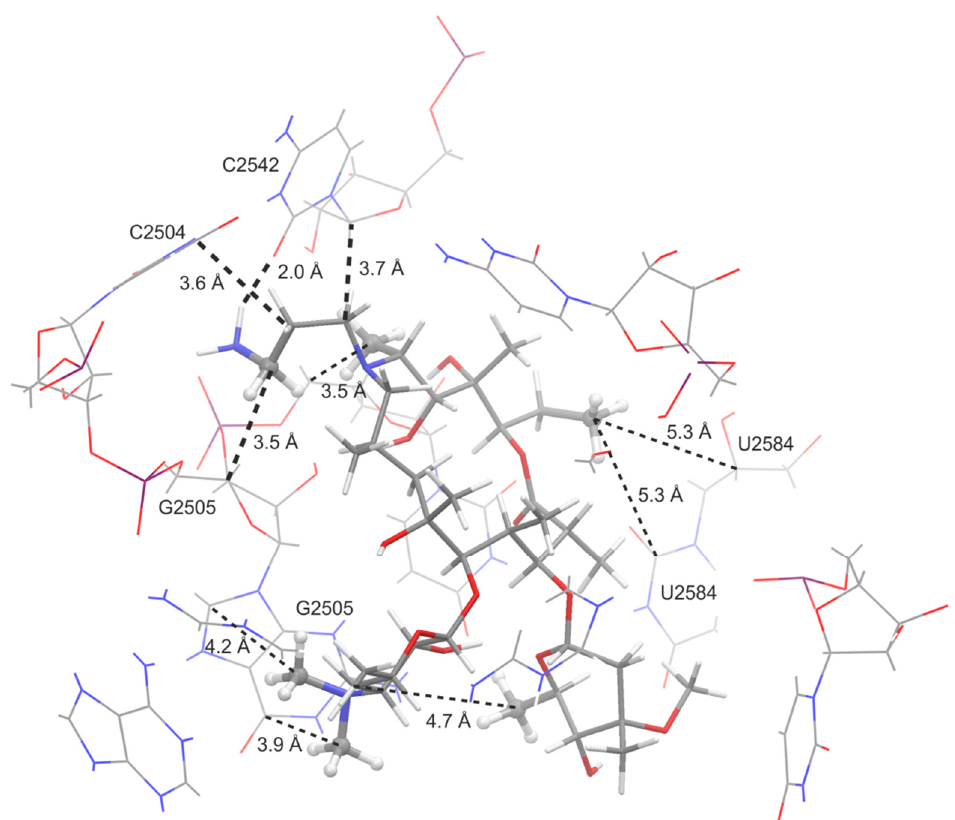
Figure 8. Interactions of 1a and the main contacts with E. coli ribosome nucleotides. The contacts observed in STD experiments and docking calculations are shown as dashed lines, and the interactions between the ribosome and aminopropyl moiety are highlighted as thicker dashed lines.